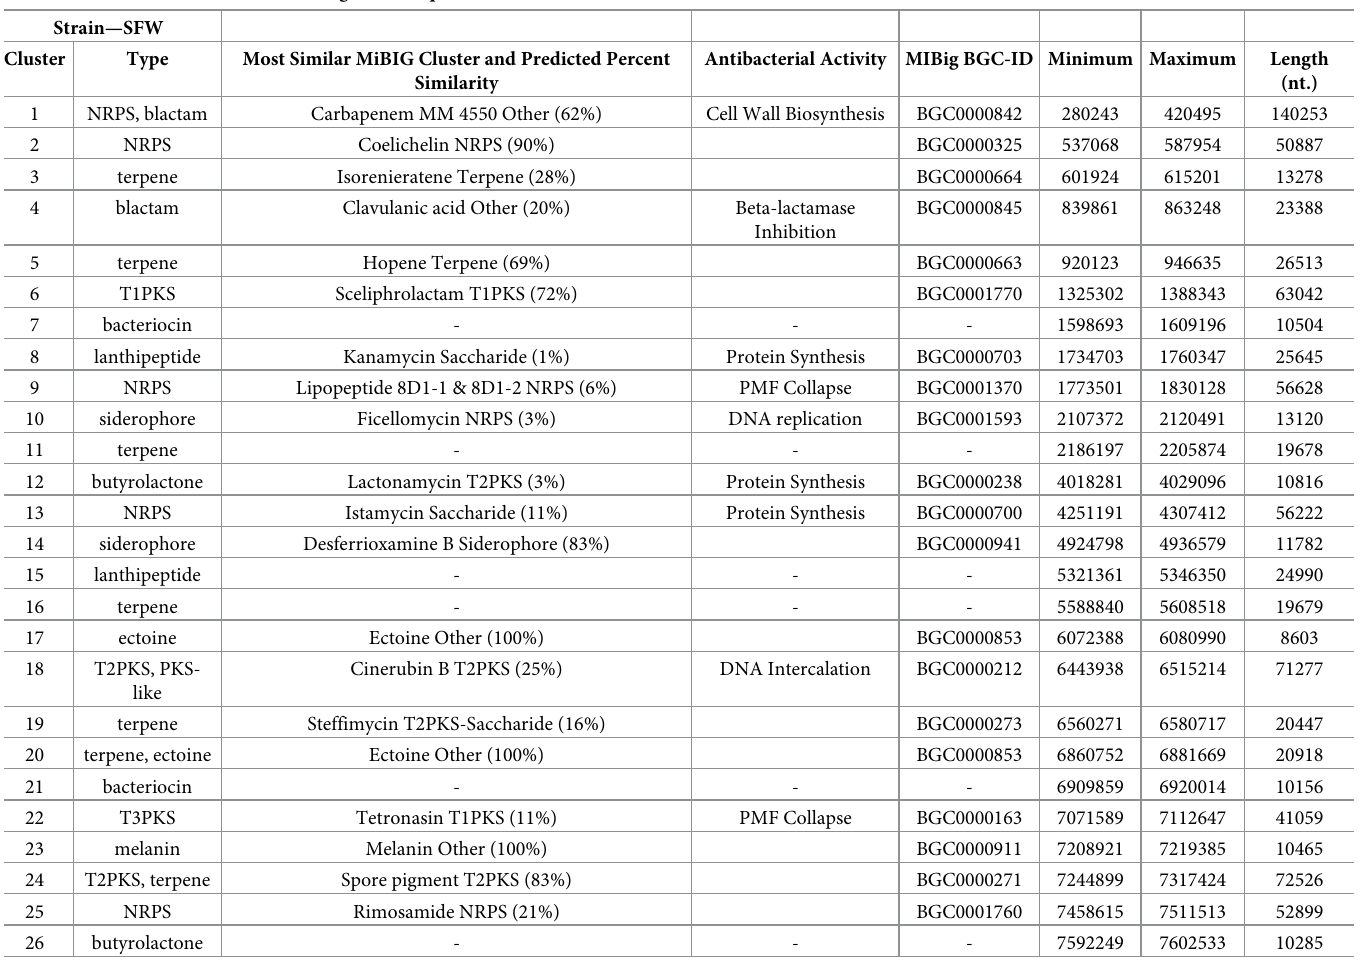
Table 4. BGCs encoded within the draft genome sequence of strain